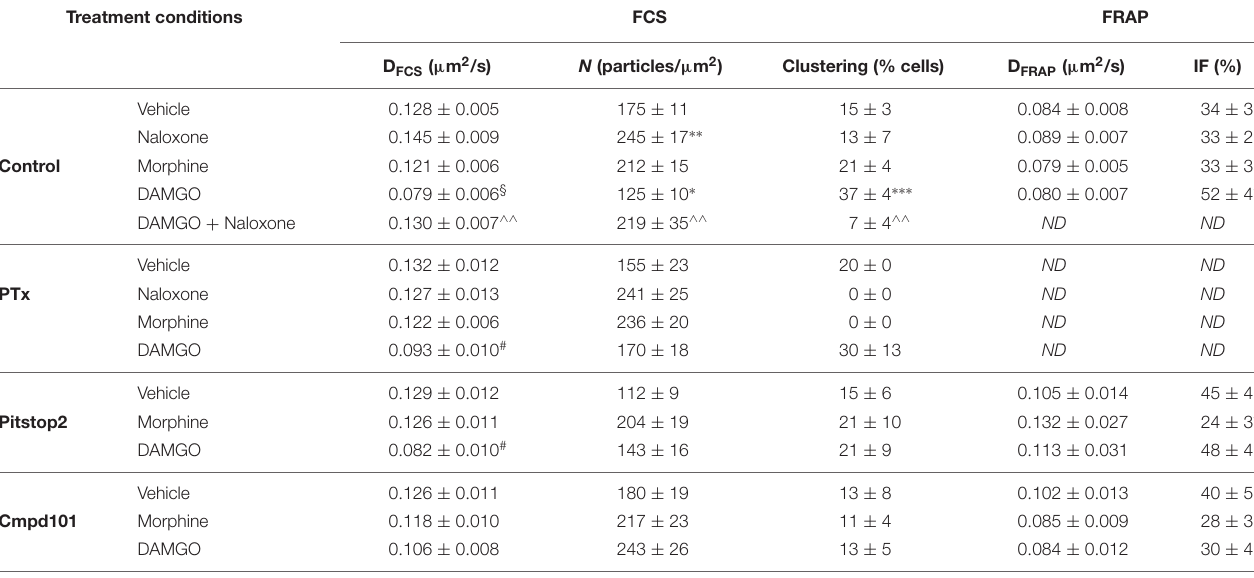
TABLE 1 | Diffusion coefficient (D FCS ), particle concentration (N) and clustering measured by FCS and diffusion coefficient (D FRAP ) and immobile fraction (IF) measured by FRAP of SNAP-MOP expressing cells under different treatment